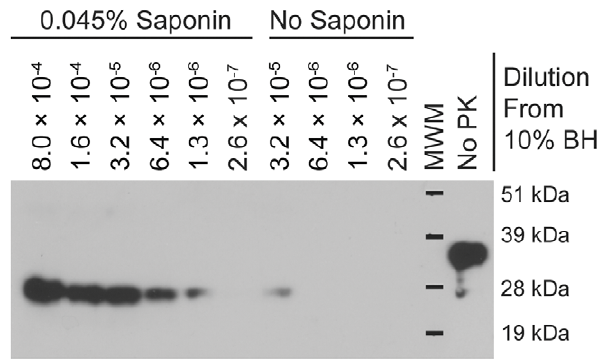
Figure 2. Saponin increases the sensitivity of PMCAb for PrP CWD detection. CWD-positive brain homogenate (BH; 10% w/v) was diluted using serial five-fold dilutions in NBH and subjected to one round of 96-cycle PMCAb in the presence of absence of 0.045% saponin. BH, brain homogenate; MWM, molecular weight marker.